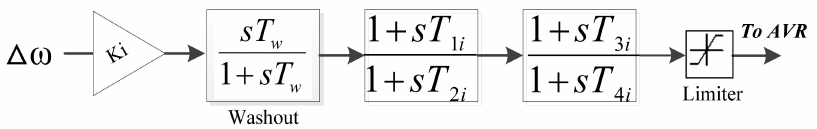
Figure 3. Lead-lag